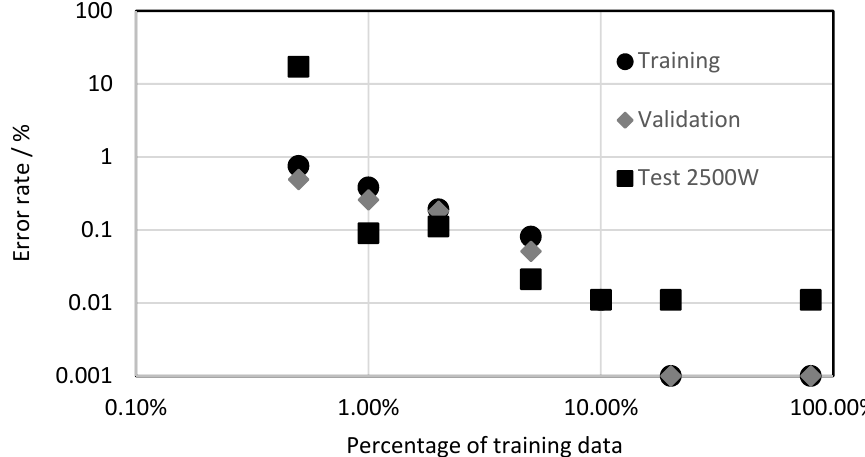
Figure 6. Error rate as a function of the training image percentage.